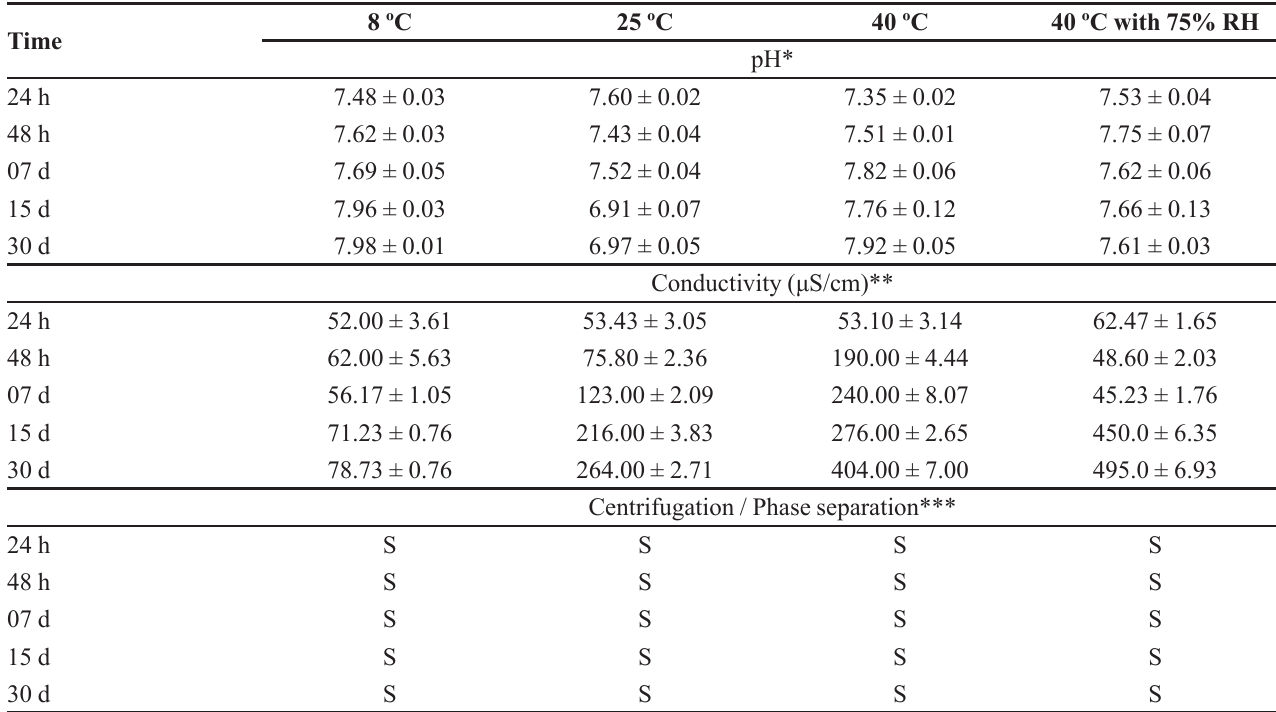
TABLE III - Centrifugation, mean conductivity and pH values of MeB samples kept in different storage conditions